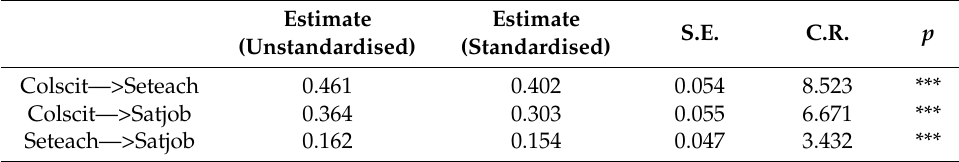
Table 5. The weights of the regression model.